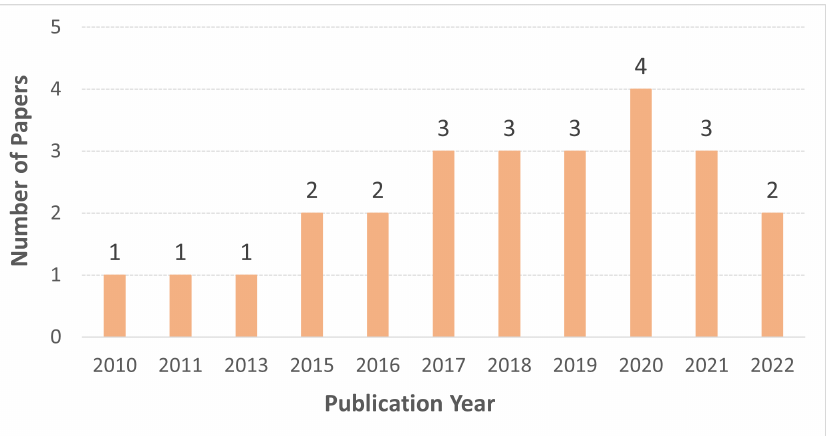
Figure 4. Publication Year of the Reviewed